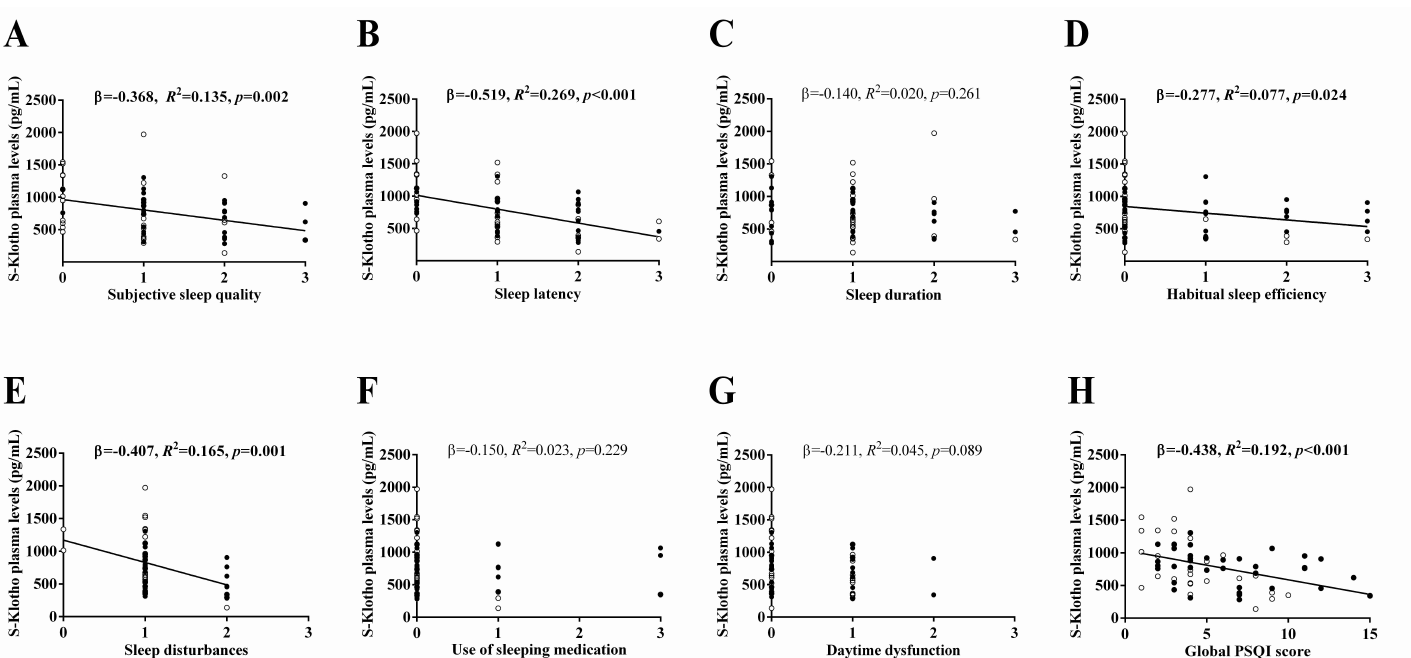
Figure 2. Association of subjective sleep quantity and quality (components and global PSQI score) with the S-Klotho plasma levels in sedentary middle-aged adults. β (standardized regression coe ffi cient), R 2 , and p from a simple linear regression analysis. Significant p values ( < 0.05) are highlighted in bold. Open circles represent men, close circles represent women, and the straight solid line represents the regression line. S-Klotho = Secreted Klotho; PSQI = Pittsburgh Sleep Quality